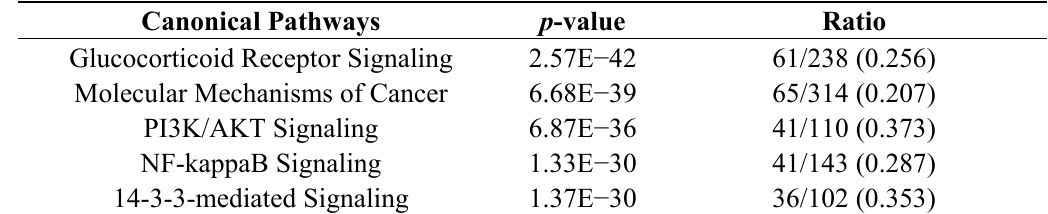
Table 4. Key canonical pathways associated with the common network using IPA.